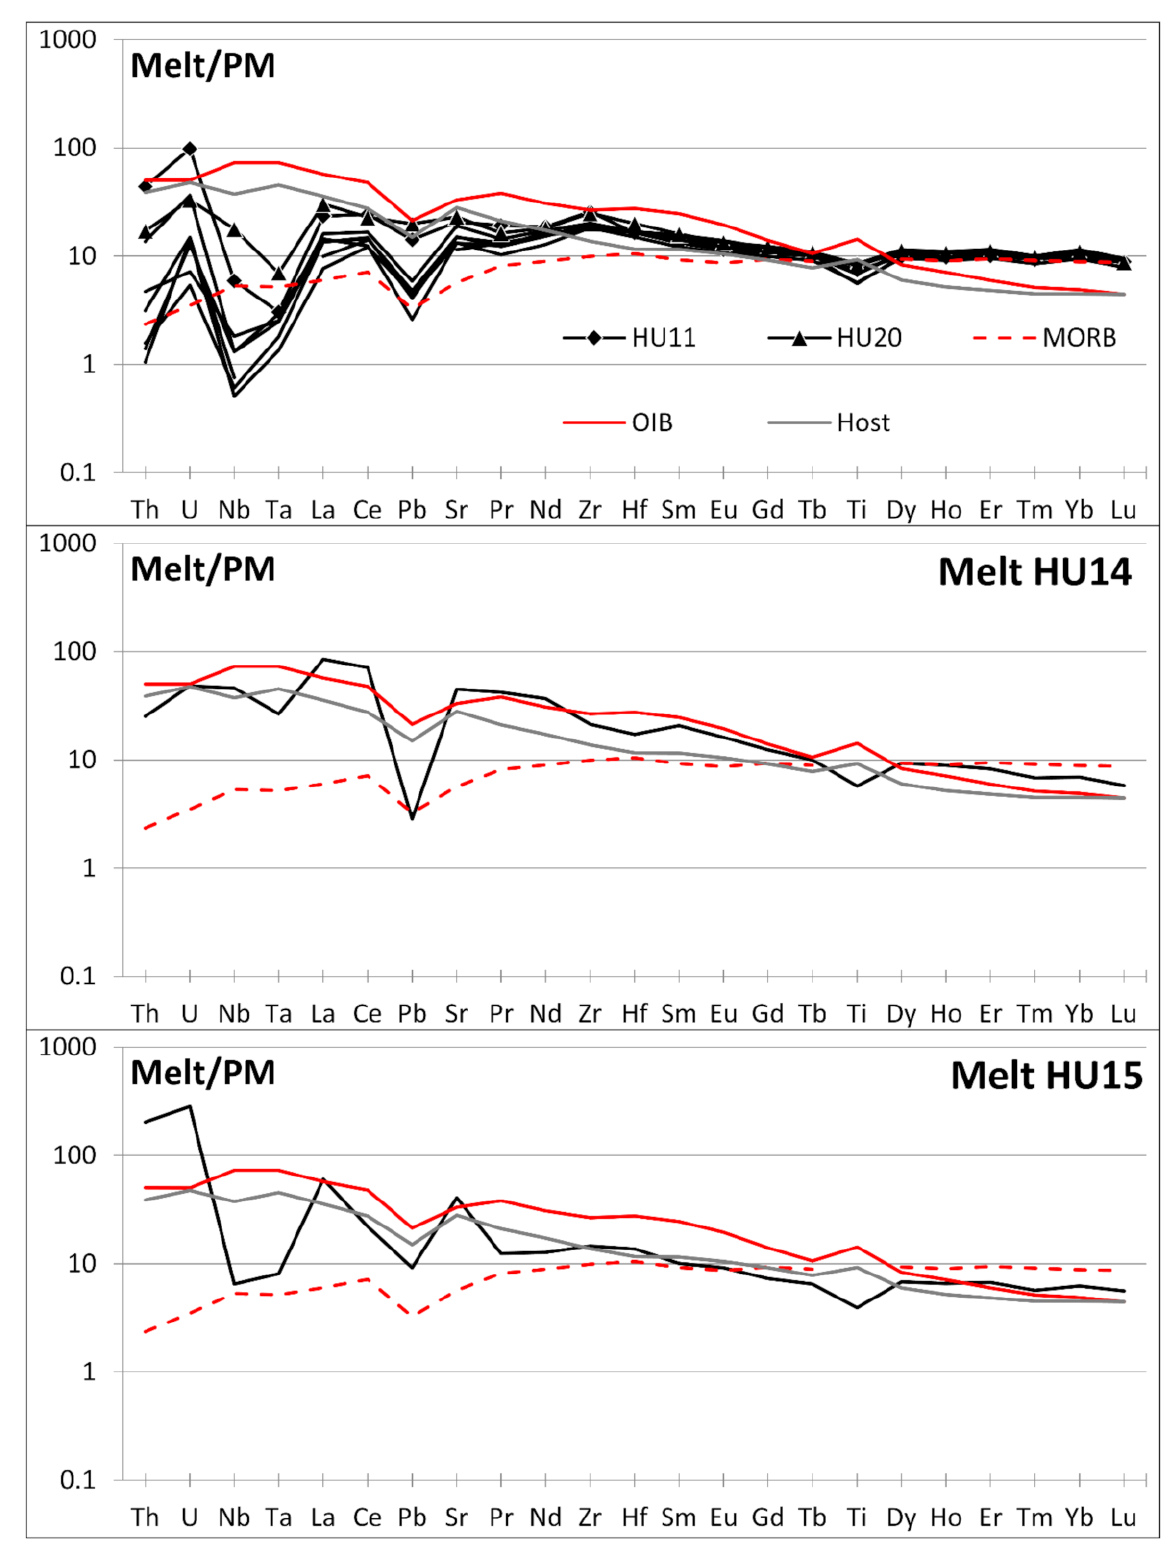
Figure 9. Spiderdiagrams of melts in equilibrium with clinopyroxene calculated using the parti- tion coefficients of Ionov et al. [51]. Values are normalized to Primitive Mantle (PM) values from McDonough and Sun